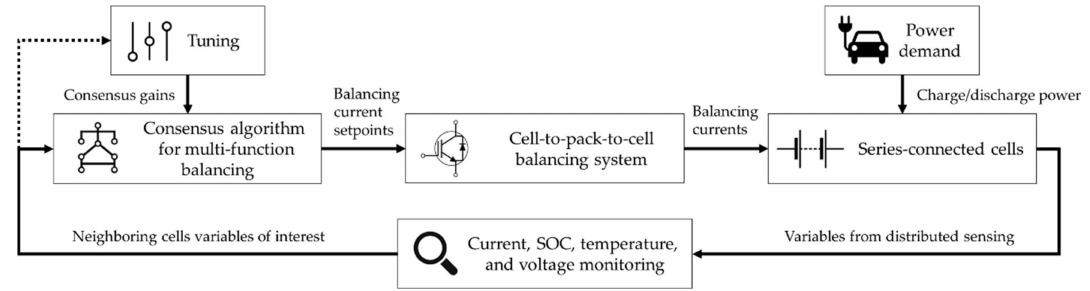
Figure 5. Block diagram of the distributed consensus control framework for multi-function EV battery balancing.